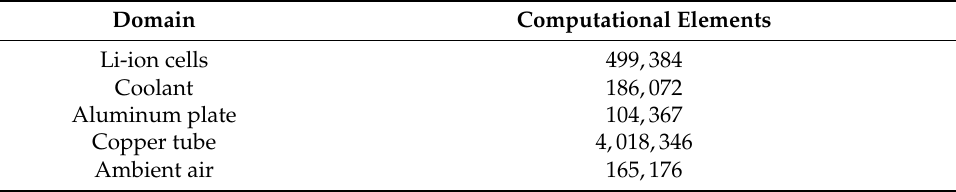
Table 6. Computational elements in medium grid for cold-plate